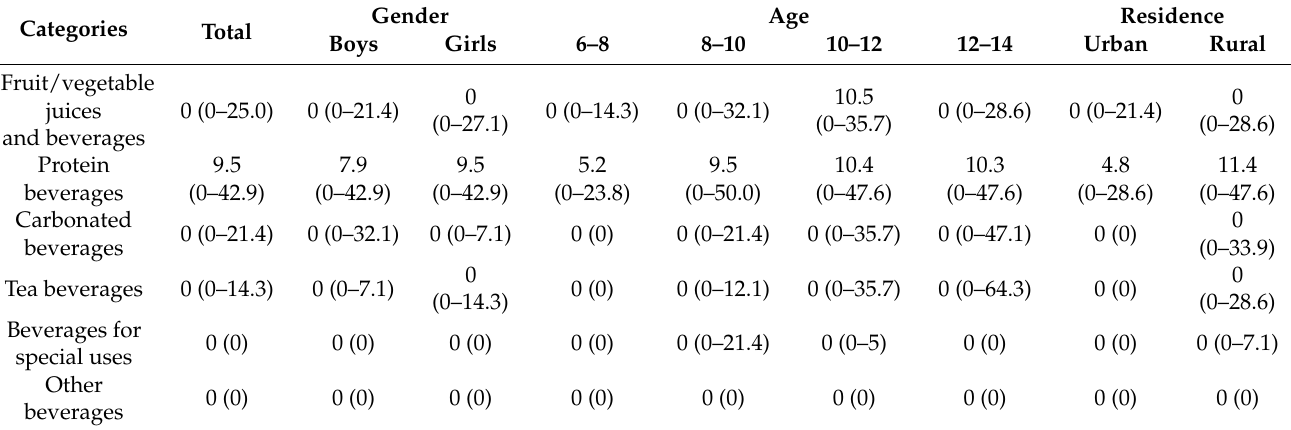
Table A6. Description of single beverage consumption quantity among students (mL/d, P50